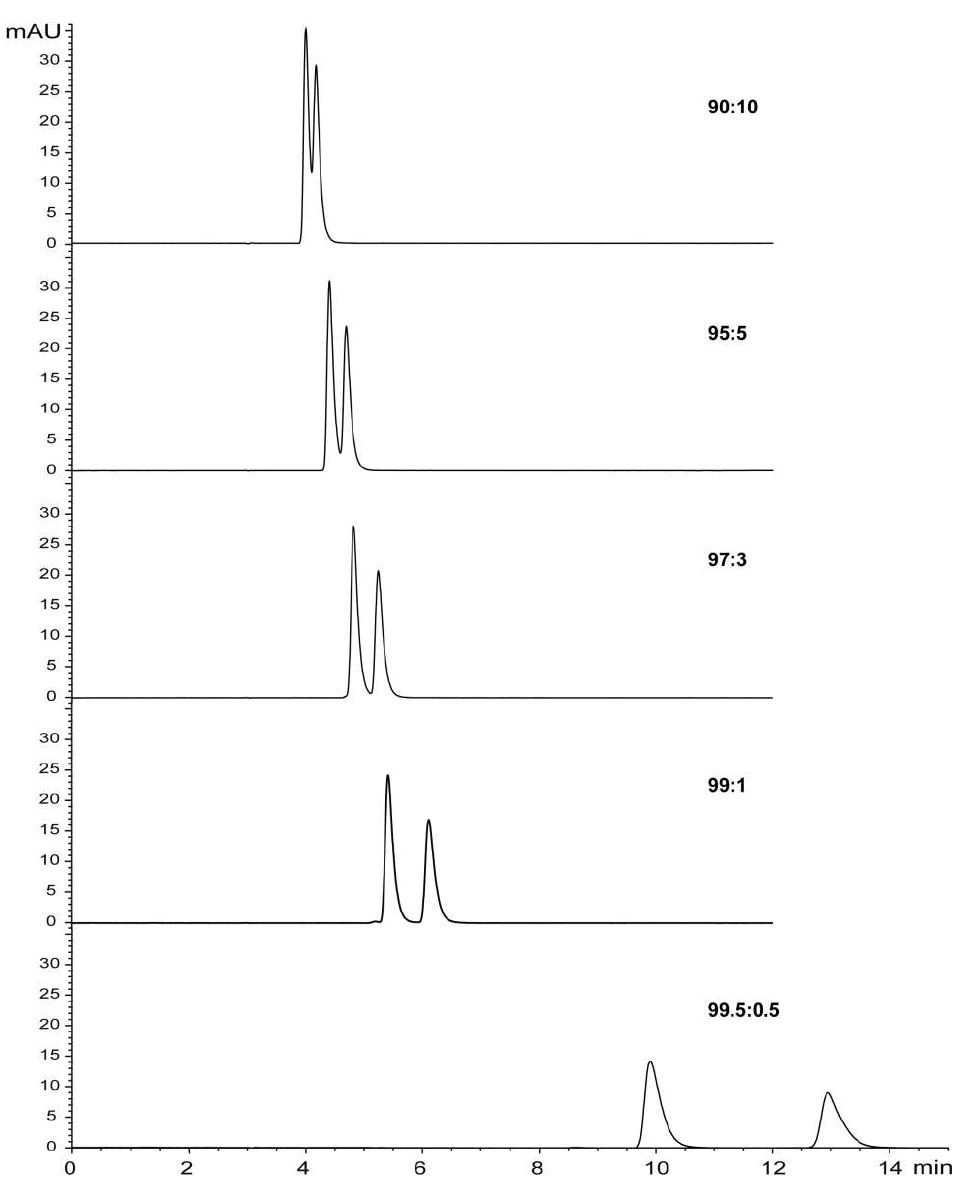
Figure 3. Chromatograms obtained from HPLC analysis of EMP using hexane/isopropanol as eluent.